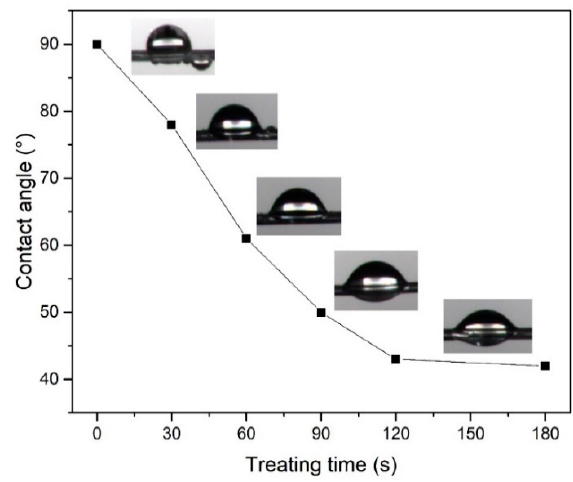
Figure 7. Influence of DBD plasma treatment duration on contact angle.